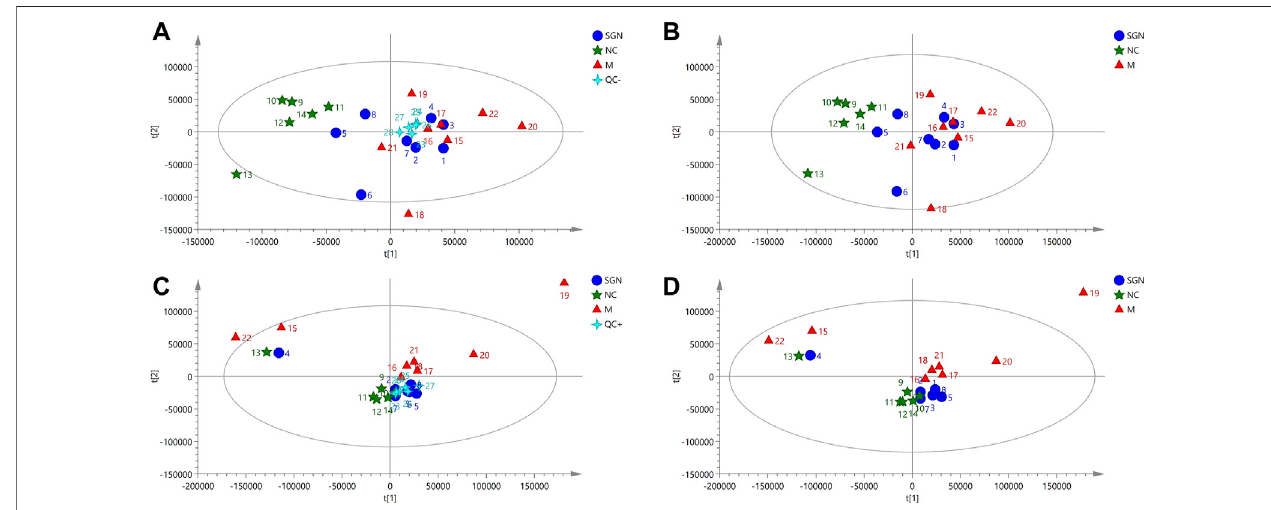
FIGURE 3 | PCA score plots of serum in positive and negative